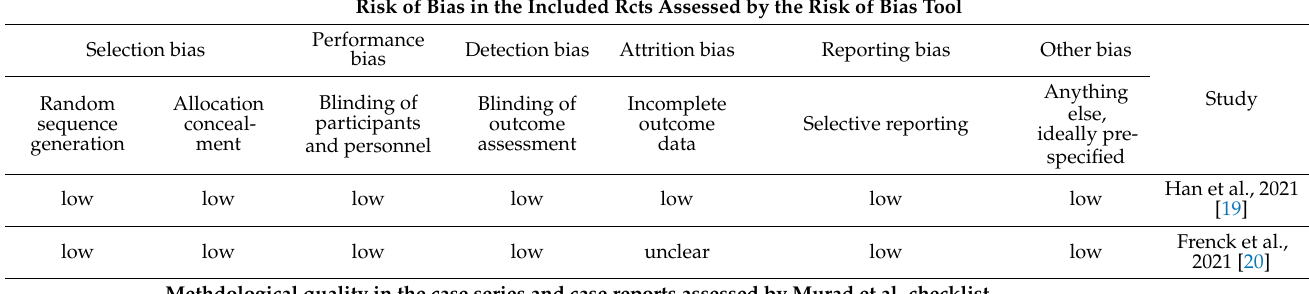
Table 2. Quality assessment of included